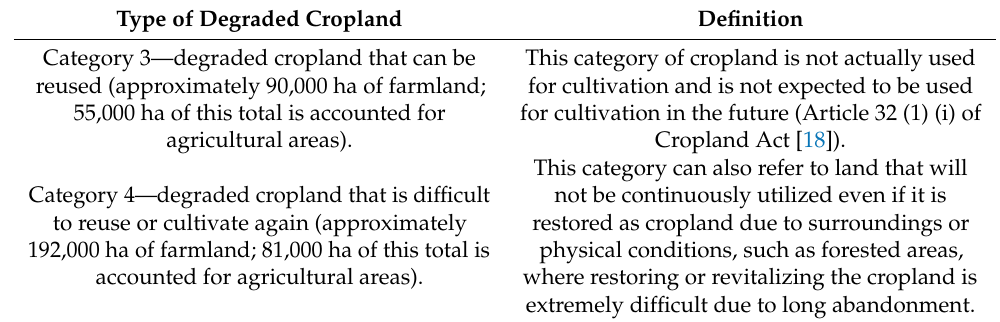
Table 1. Classification of degraded cropland (determined annually by field surveys of the MAFF [21]).